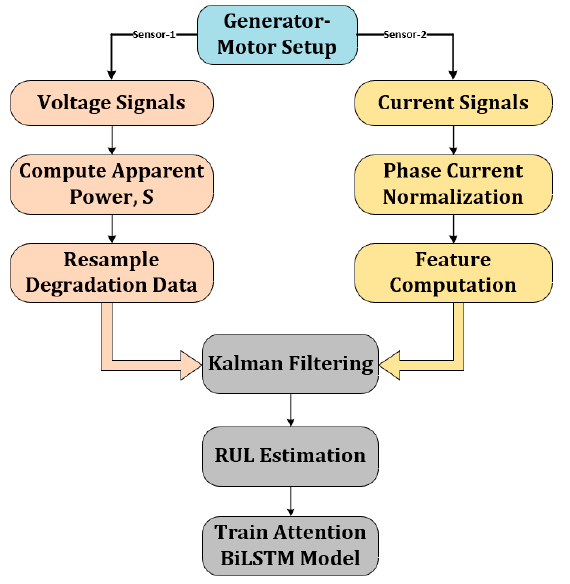
Figure 1. Graphical illustration of the proposed RUL estimation method.